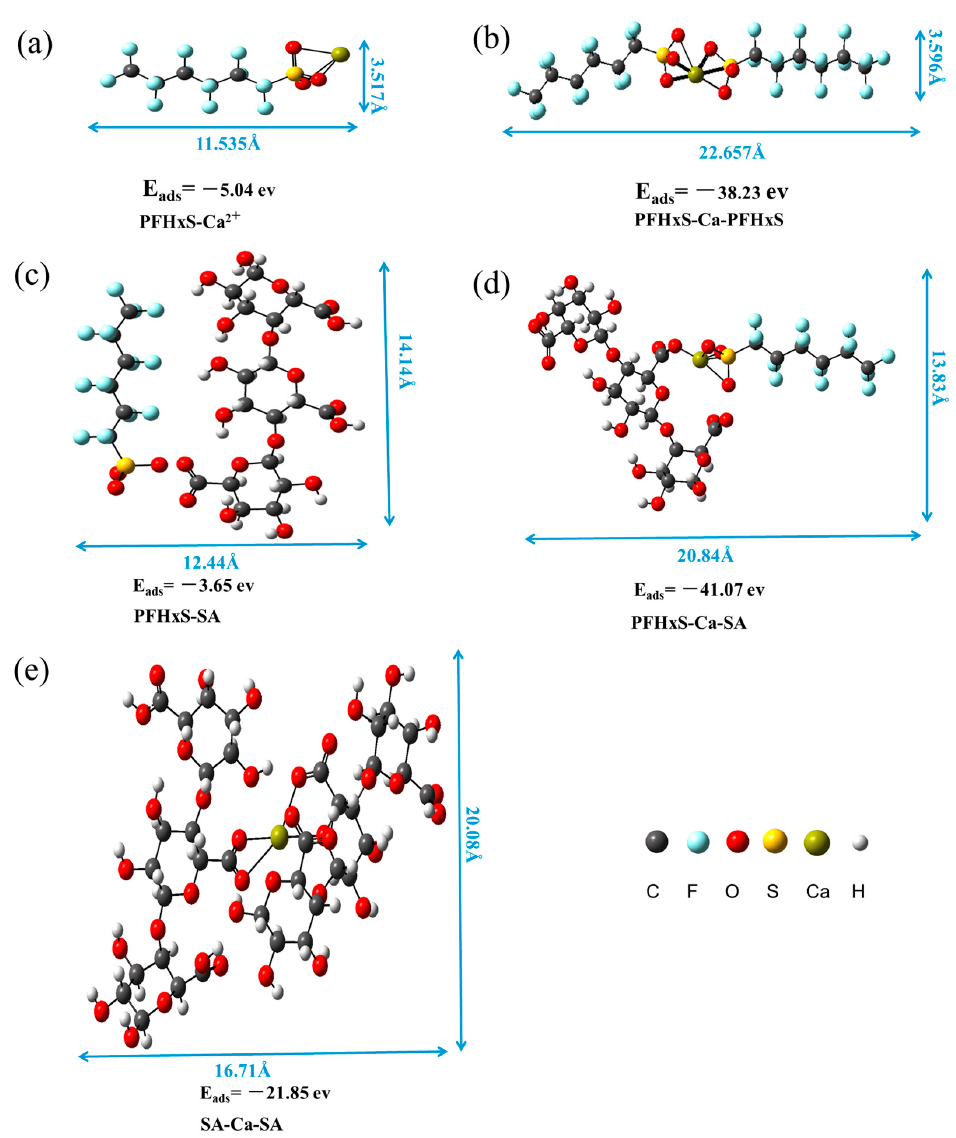
Figure 6. The configuration and interaction energy of PFHxS combined with Ca 2+ or/and SA. ( a ) a Ca 2+ ion bound to one PFHxS molecule, ( b ) a Ca 2+ ion bound to two PFHxS molecules, ( c ) a SA bound to one PFHxS molecule, ( d ) a Ca 2+ ion bound to one PFHxS molecule and one SA molecule, ( e ) a Ca 2+ ion bound to two SA molecules.